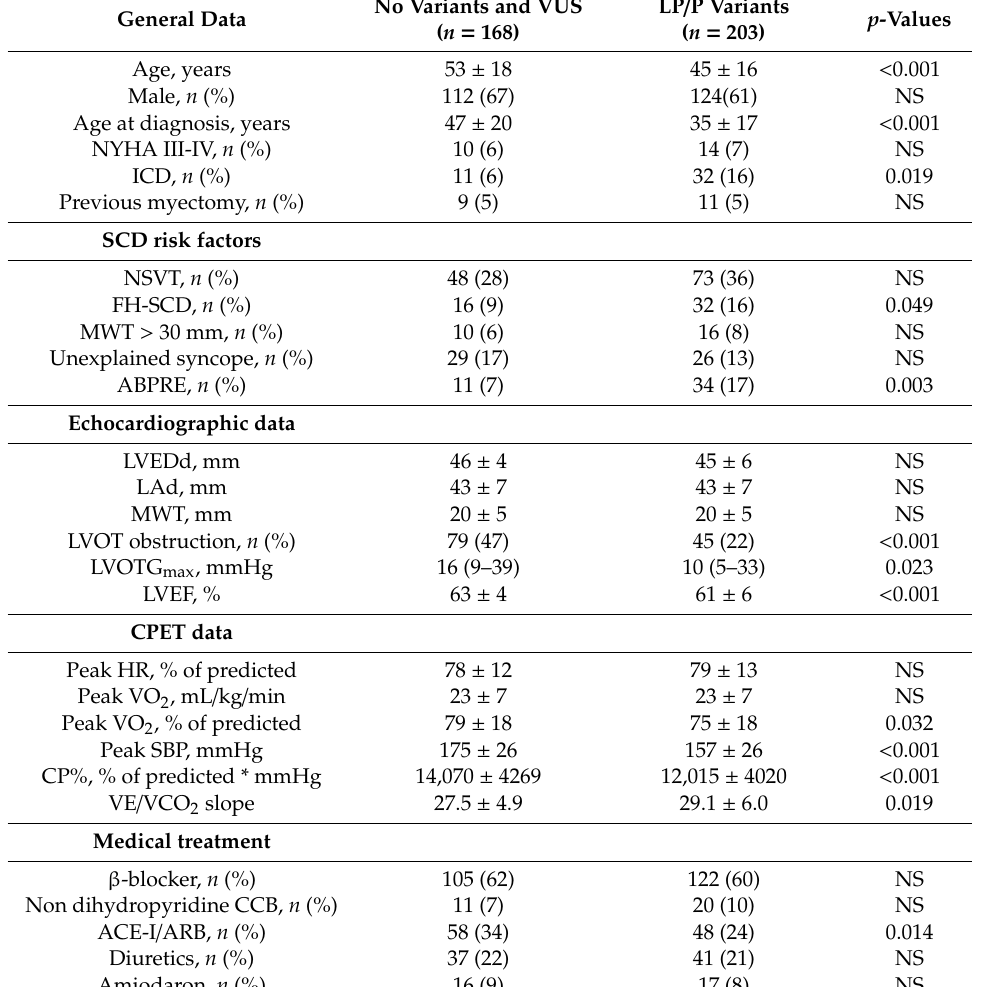
Table 2. Main clinical variables of the study sample at the study run-in according to genetic testing